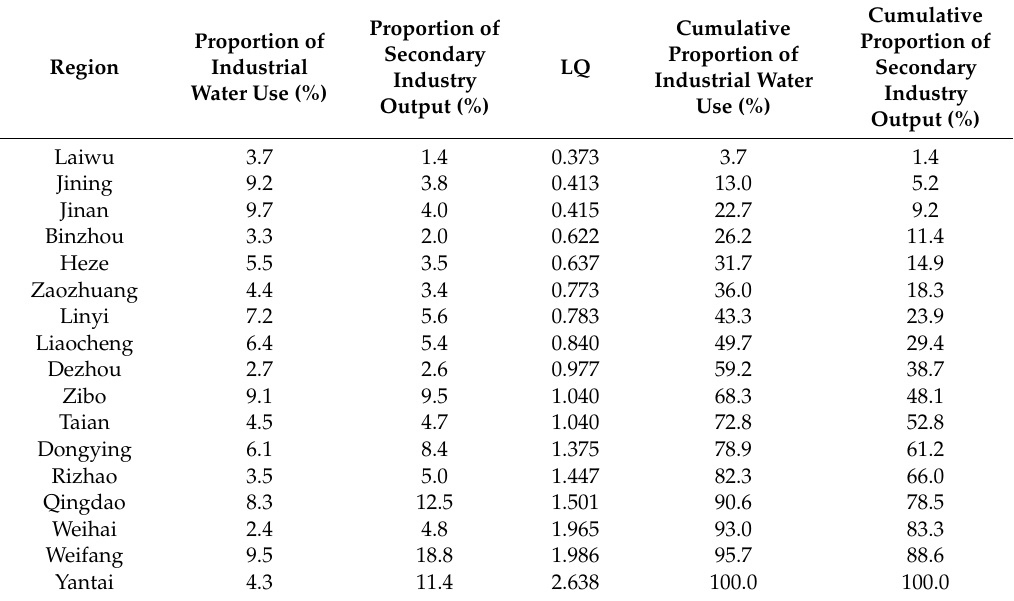
Table 8. Calculation of industrial water use Gini index based secondary industry output of Shandong in 2017. Proportion of Region Industrial Water Use (%)